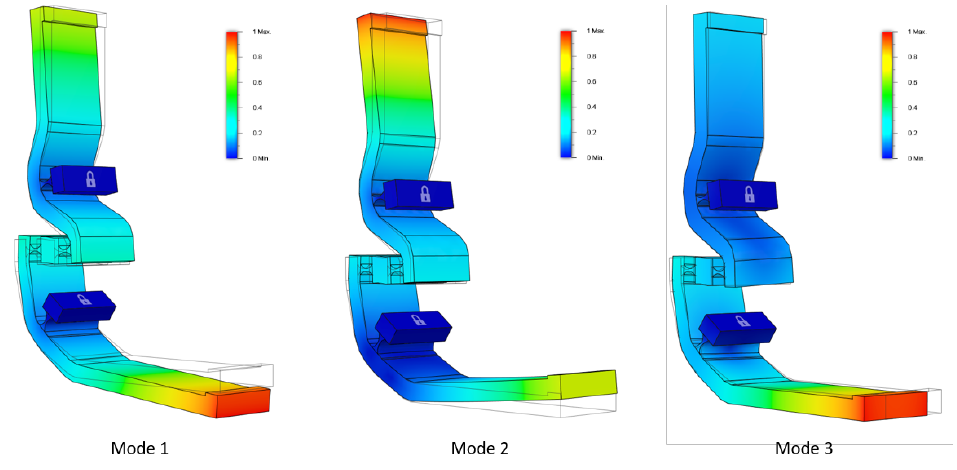
Figure 5. FEM modal analysis of the flexure hinge mechanism (0.1 mm hinges